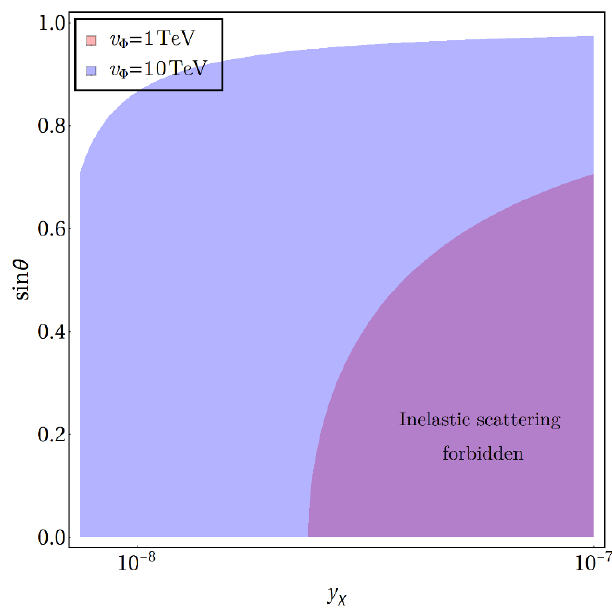
Figure 5 . Choice of Yukawa y (cid:31) and VLF mixing sin (cid:18) (via eq. (4.8)) in order to forbid the inelastic scattering via heavy neutral gauge bosons. The purple and pale blue regions correspond to v (cid:8) : f 1 ; 10 g TeV respectively. Each colored region is where inelastic scattering gets